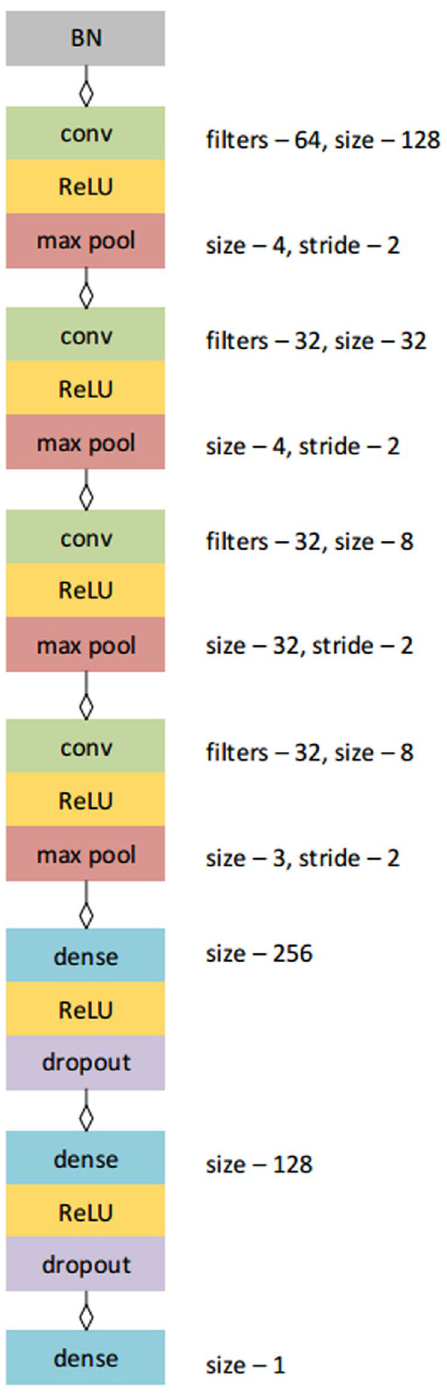
Figure 3. Architecture of convolutional neural network. The same network architecture was used to train both models for predicting age and for predicting mortality